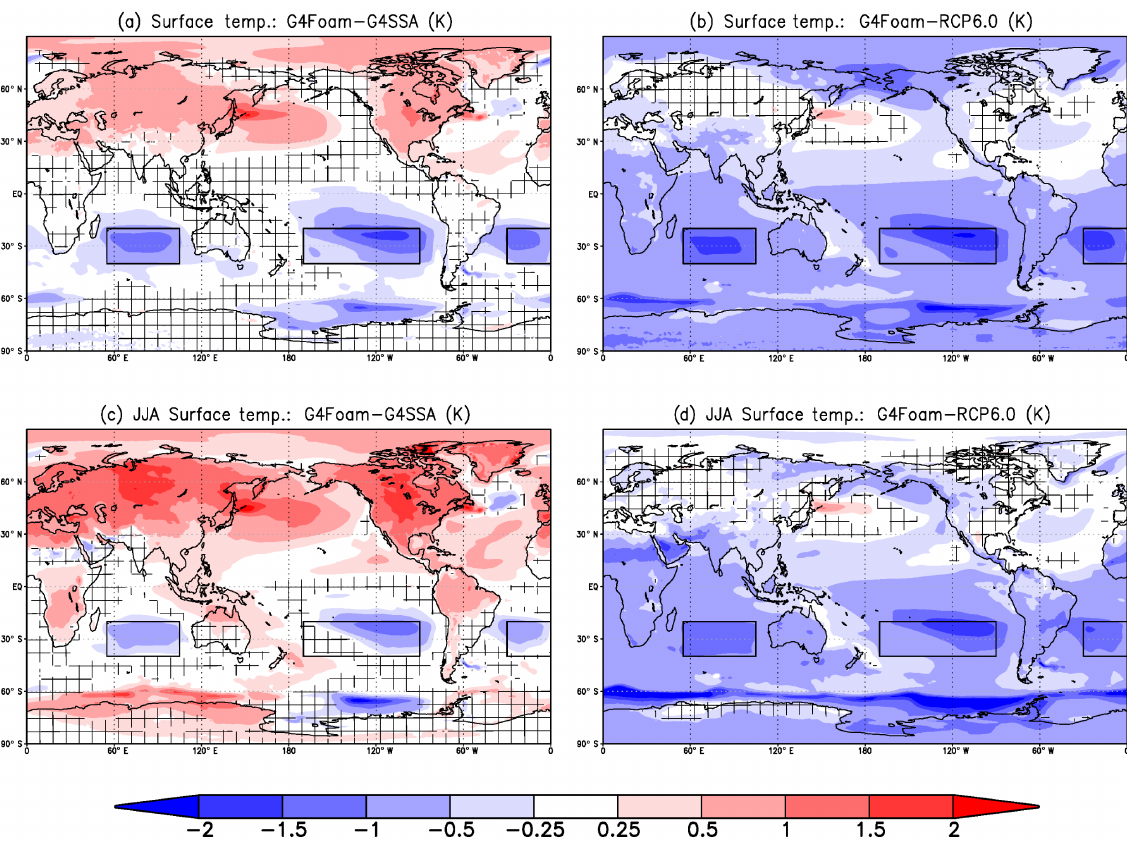
Figure 4. 2030–2069 surface temperature differences (K) between G4Foam and (a) G4SSA, (b) RCP6.0, (c) G4SSA during JJA, and (d) RCP6.0 during JJA. Hatched regions are areas with p >0.05 (where changes are not statistically significant based on a paired t test). Black boxes enclose foamed